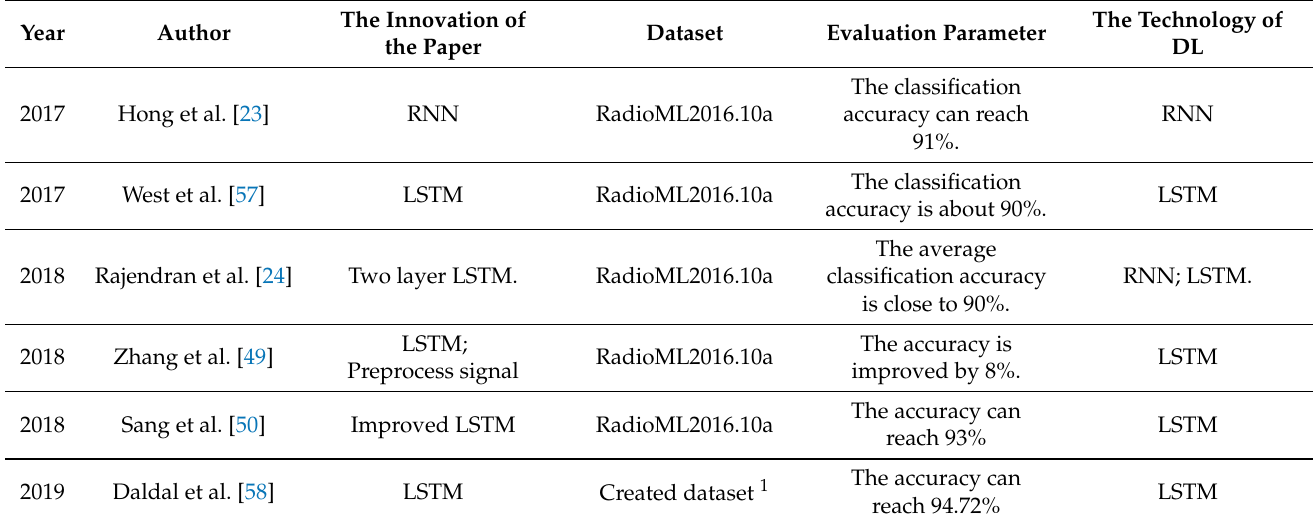
Table 3. Radio modulation recognition networks based on RNN and LSTM.